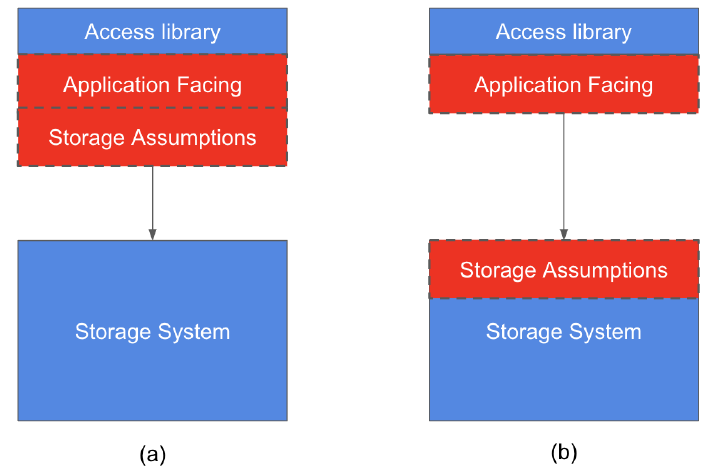
Figure 1. Access Library